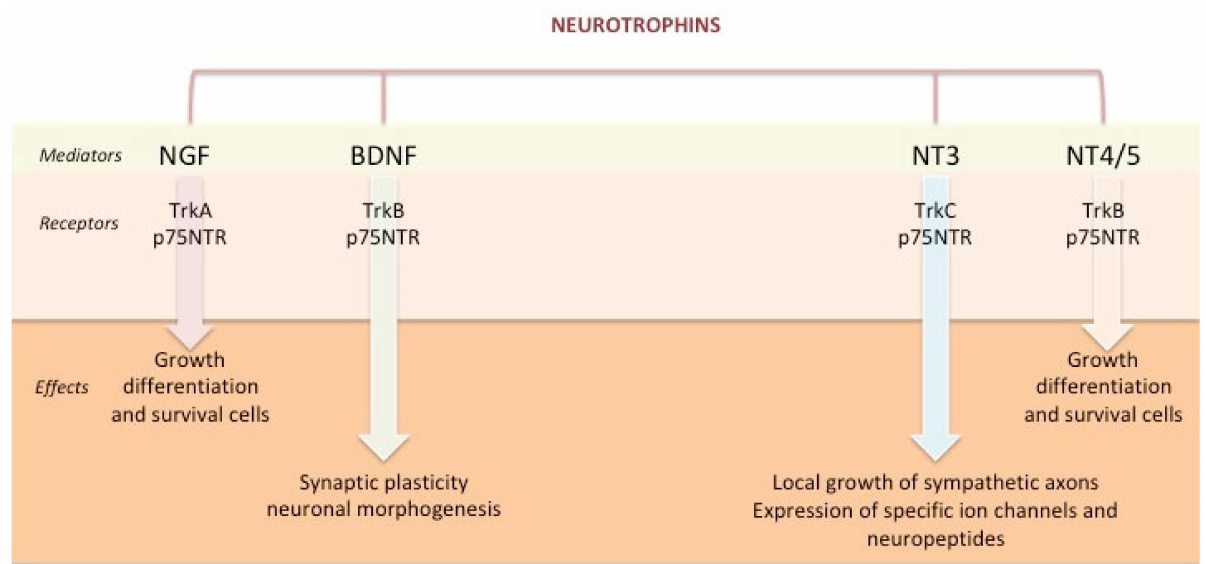
Figure 1. Neurotrophins: Role and effects. Legend: NGF = nerve growth factor; BDNF = brain- derived neurotrophic factor; NT = neurotrophin; Trk = tropomyosin-related kinase P75 NTR = P75 neurotrophin